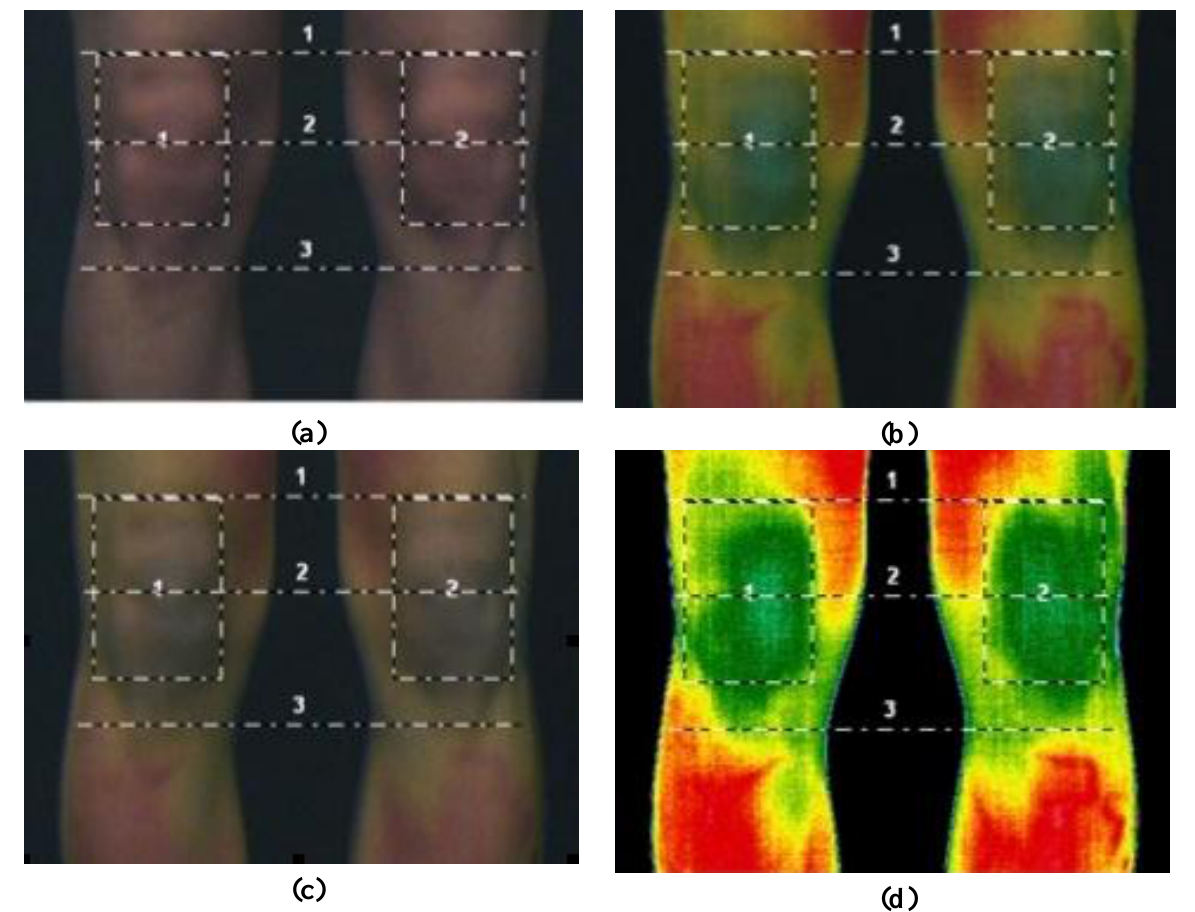
Figure 2. Process of image fusion. (a) Anatomical image; (b) Image fusion first step; (c) Image fusion second step; (d) Infrared